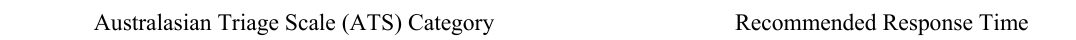
Patient categories and recommended response times